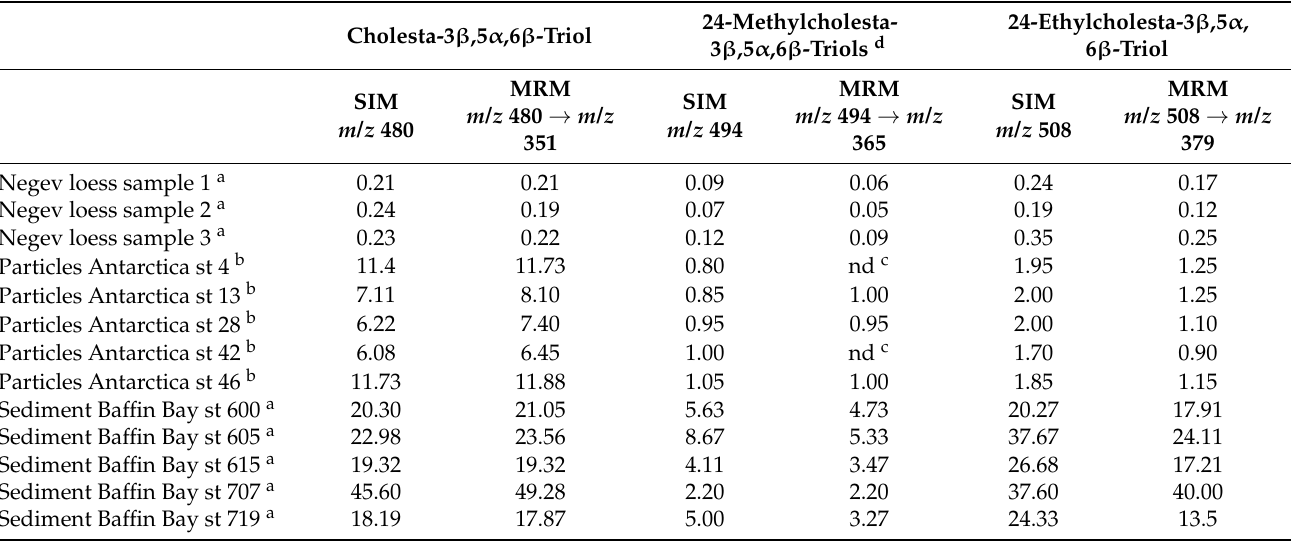
Table 4. Concentrations of saturated 3 β ,5 α ,6 β -steratriols in several environmental samples, measured after trifluoroacetylation in SIM and MRM modes.